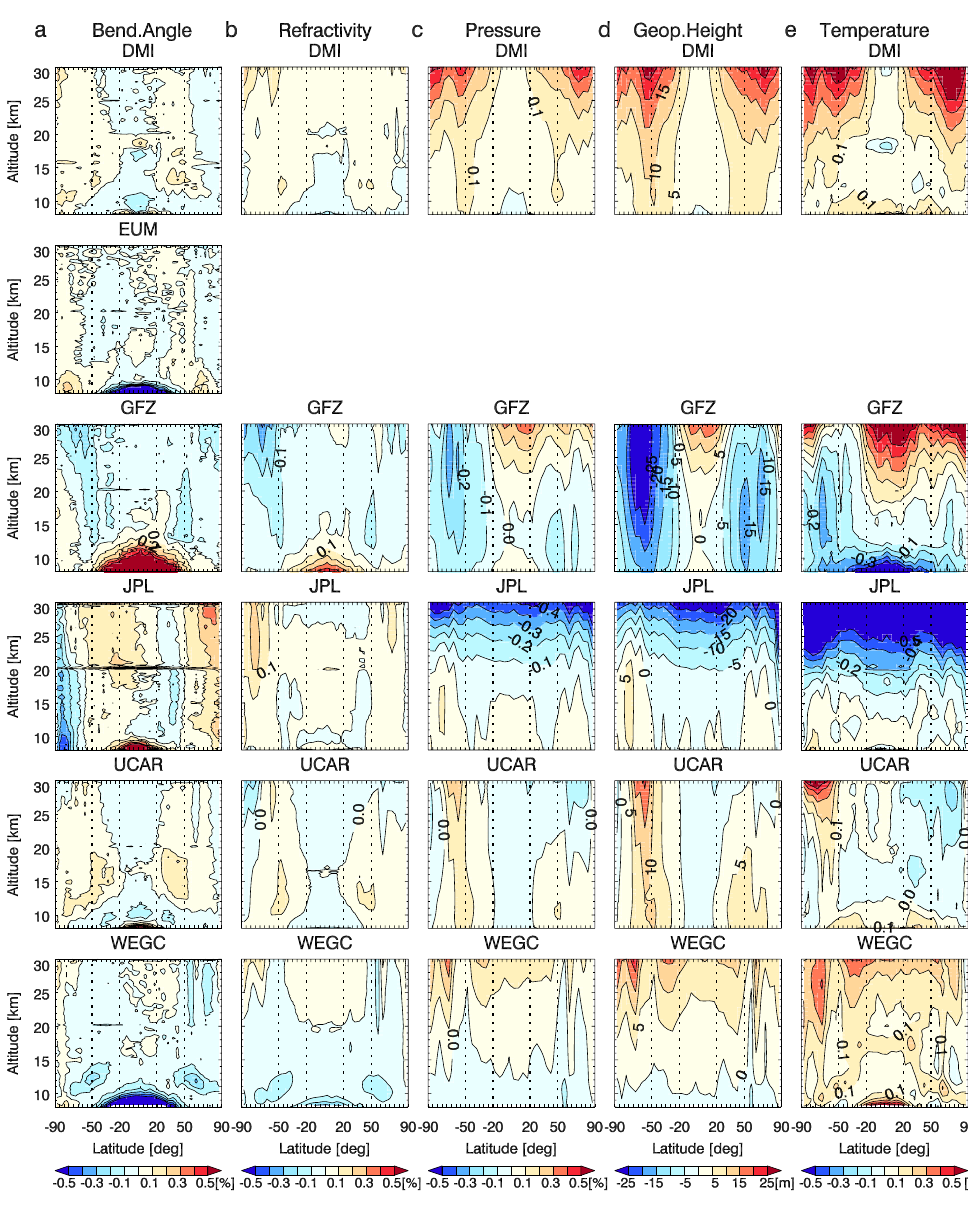
Fig. 1. Mean difference of each center (top to bottom; DMI, EUM, GFZ, JPL, UCAR, WEGC) to the all-center mean for the period September 2001 to September 2008, shown for (a) bending angle, (b) refractivity, (c) pressure, (d) geopotential height, and (e) temperature.